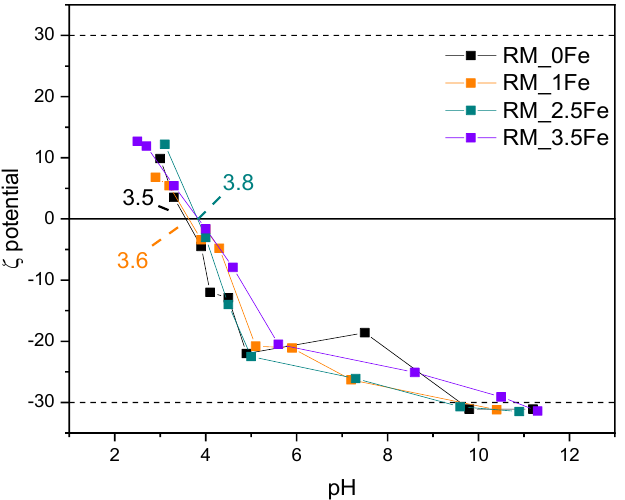
Figure 8. ζ -potential curves of the studied samples: RM_0Fe (black curve), RM_1Fe (orange curve), RM_2.5Fe (green curve) and RM_3.5Fe (violet curve).